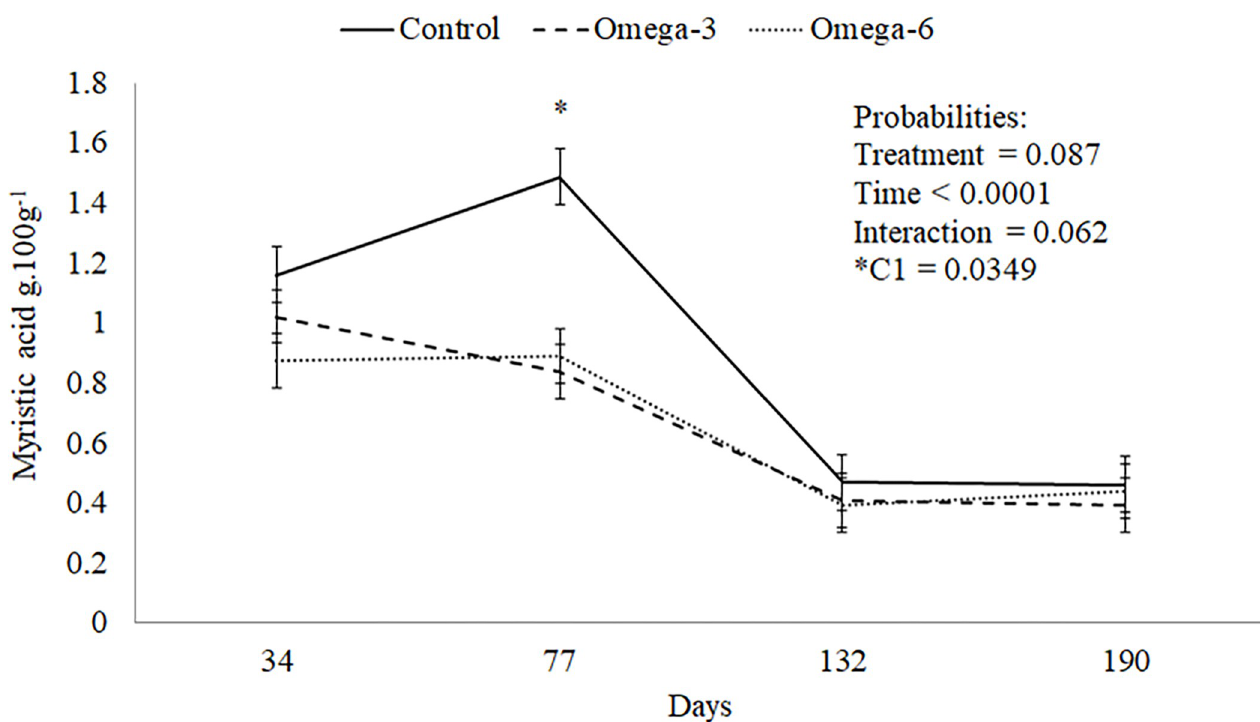
Fig 1. Tendency to increase myristic acid for Control treatment at 77 days of age of gilts.